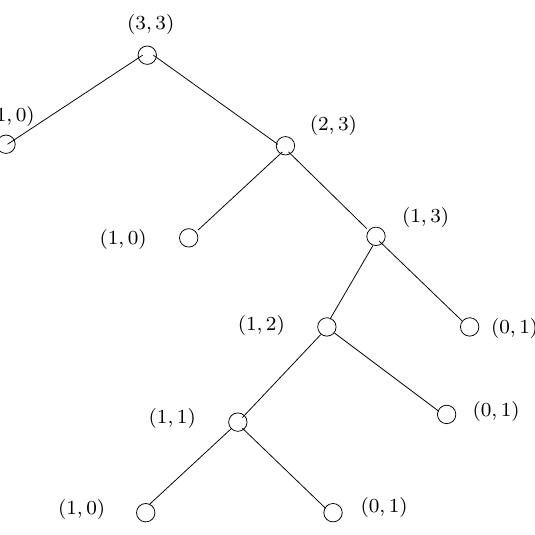
Figure 1: A labeled binary tree representing a JL -coloring of K